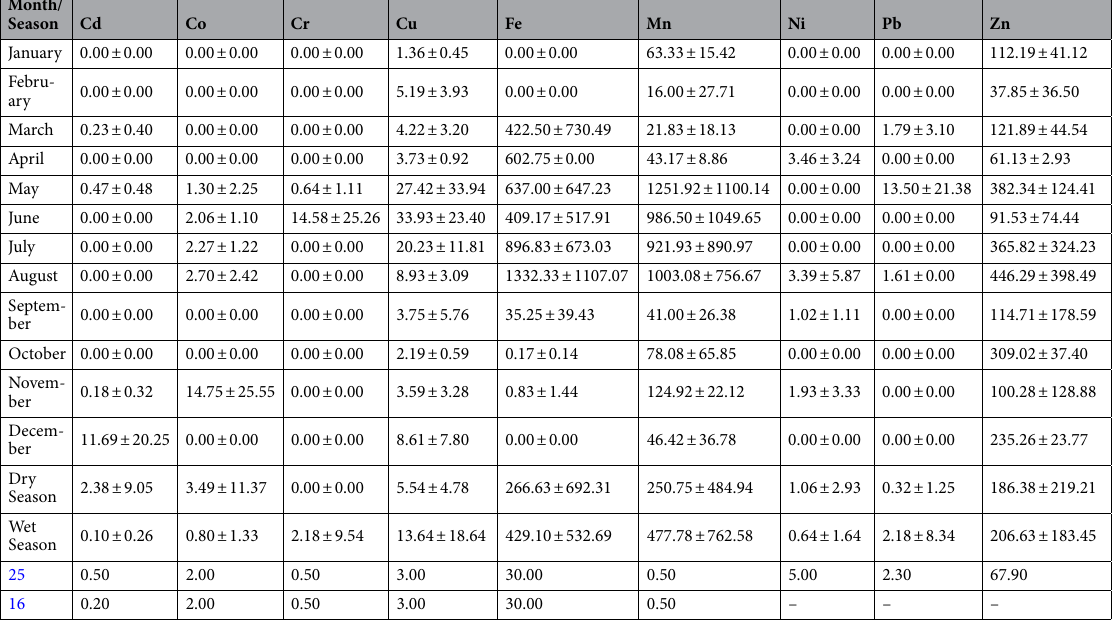
Table 1. Concentration of Heavy Metals (mg/kg) in O. niloticus in Agodi Reservoir. Source: Field Survey. (The values in the bottom rows are threshold values obtained from regulatory standards according to FAO/WHO 16 and WHO 25 ).